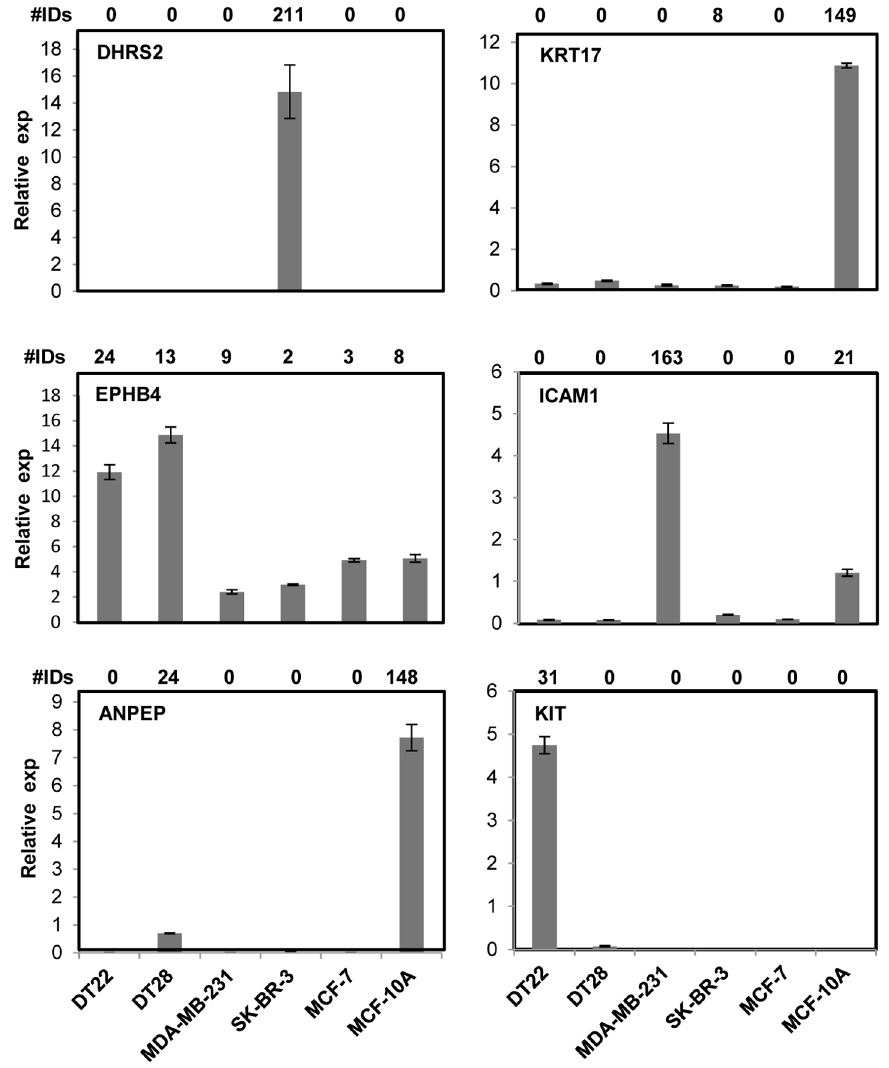
Figure 4. RT-PCR demonstrates the quantitative nature of the MS data. RNA was isolated from each of the cell lines, cDNA was made, and RT-PCR was performed to determine whether the spectral ID numbers were correlated to transcript levels of selected genes. Spectral ID numbers are displayed above each graph and the gene symbol is below those numbers.